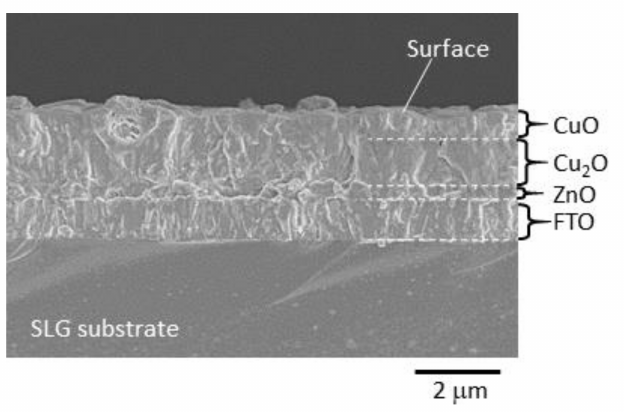
Figure 1. The cross-sectional SEM image for the CuO/Cu 2 O bi-layered film formed on a ZnO/FTO- coated